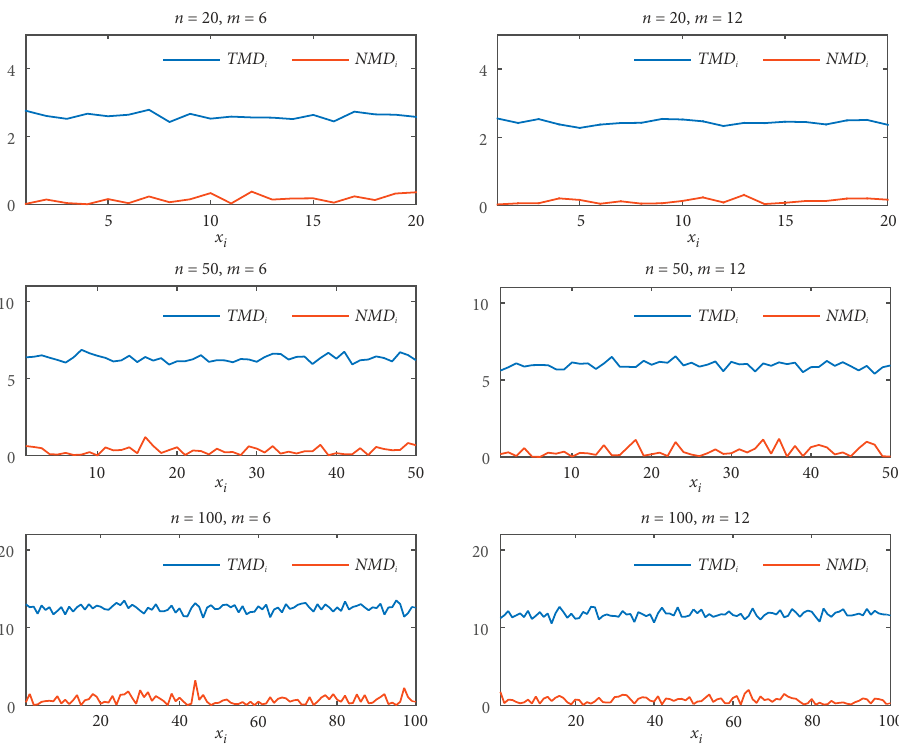
Figure 1. Average values of TMD i and NMD i ( i = 1, 2, ..., n ) under the simulation